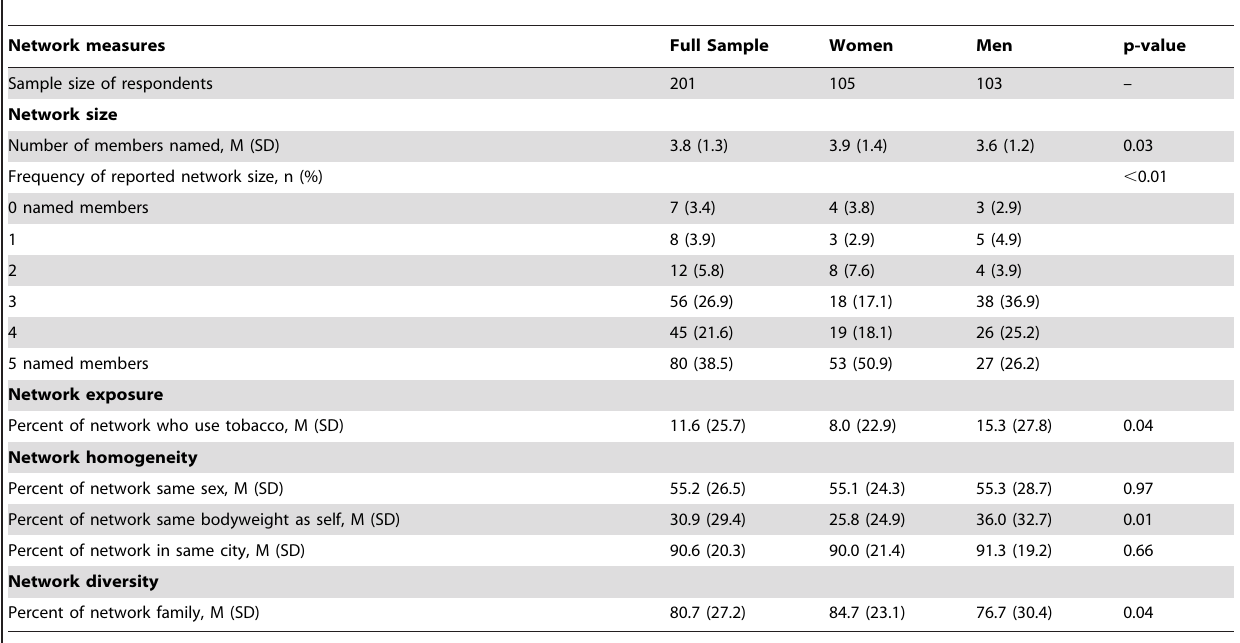
Table 3. Social network characteristics of adults in New Delhi India.